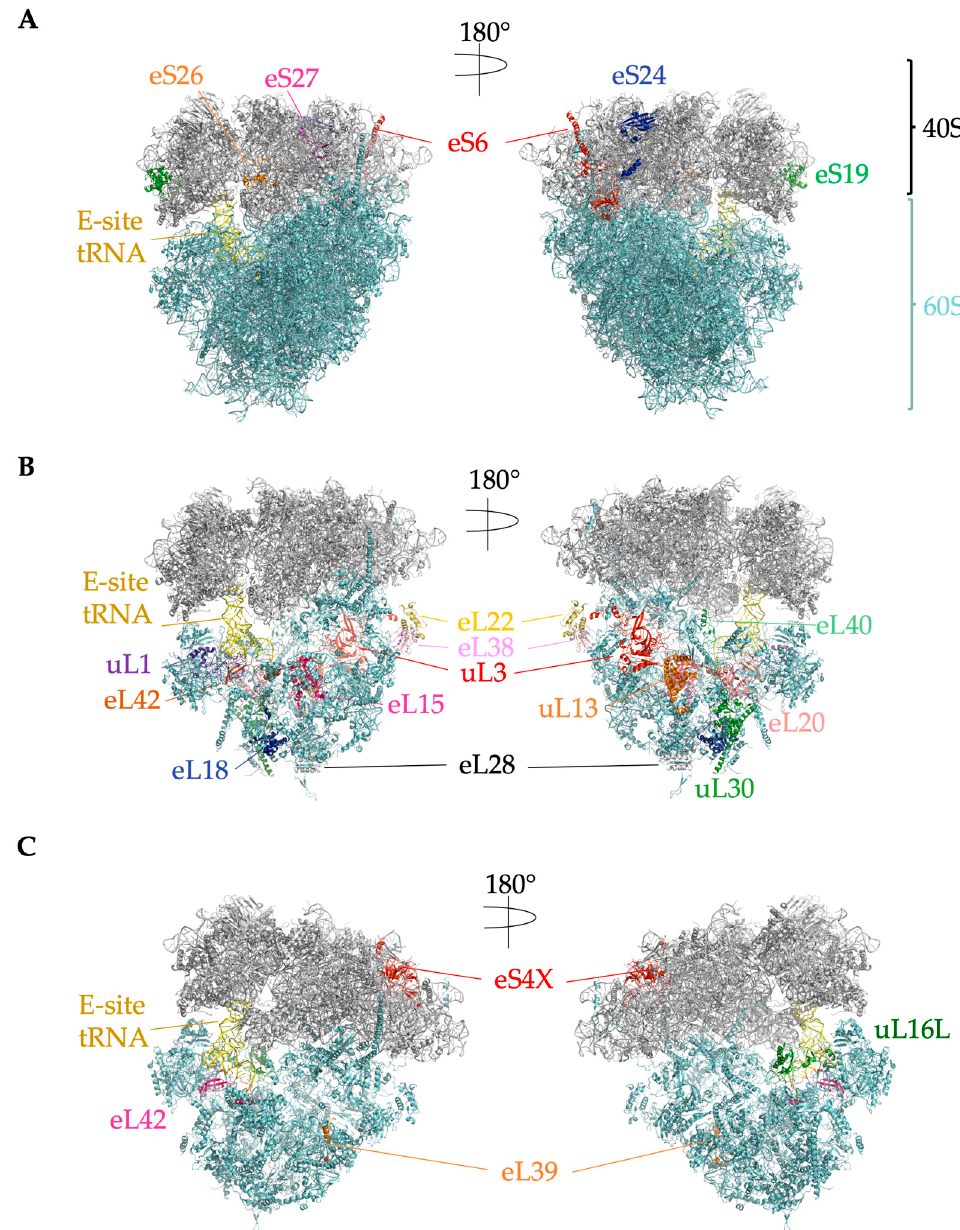
Figure 3. Locations of ribosomal proteins that are implicated in ribosome specialization. ( A ) 40S ribosomal proteins are indicated by di ff erent colors: eS26/RPS26, eS27/RPS27, eS6/RPS6, eS24/RPS24, and eS19/RPS19. The E-site of PDB 6QZP is indicated by a yellow tRNA for orientation. Both the +y and -y ribosome directions are indicated by the 180° turn. Both 40S (light gray) and 60S (cyan) are indicated. ( B ) 60S ribosomal proteins are indicated by di ff erent colors: uL1/RPL10A, eL42/RPL36A, eL18/RPL18, eL15/RPL15, eL28/RPL28, uL3/RPL3, eL38/RPL38, eL22/RPL22, uL13/RPL13A, uL30/RPL7, eL20/RPL18A, and eL40/RPL40. The E-site and ribosome directions are indicated as above. ( C ) X-linked RPs are represented by di ff erent colors: eS4X/RPS4X, eL39/RPL39, eL42/RPL36A, and uL16L/RPL10L. 28S has been hidden to show the interior proteins uL16L/RPL10L and eL42/RPL36A. The E-site, directionality, and ribosome subunits are indicated as above. This fi gure was created using PyMOL.